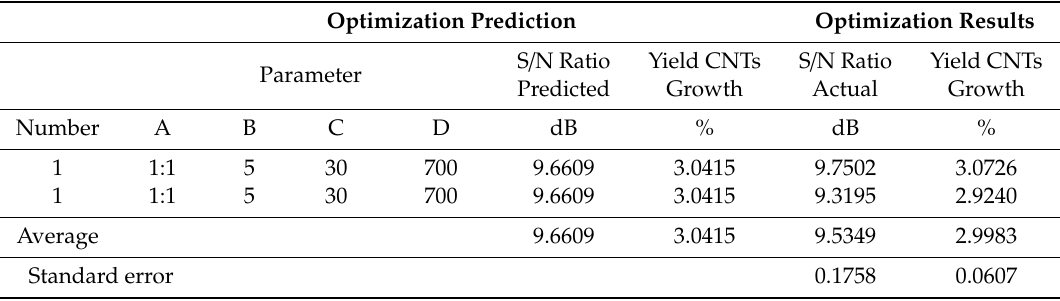
Table 4. The optimal configuration with predicted and actual S/N ratio value.